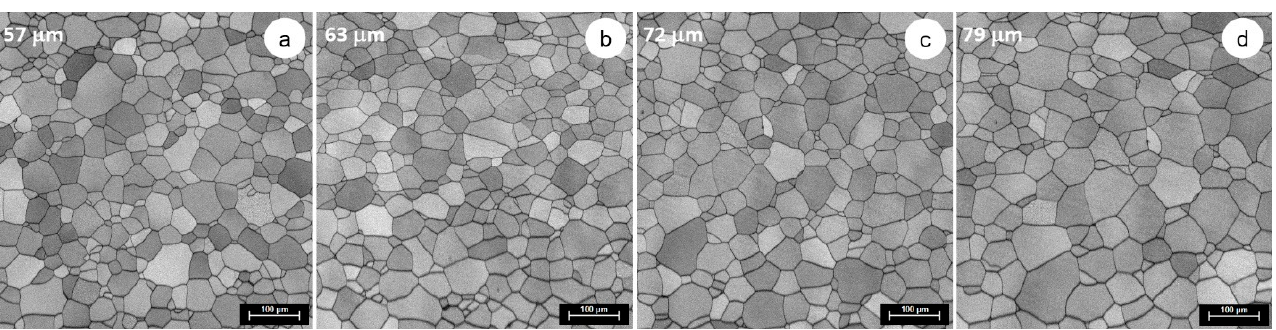
Figure 8. Evolution of the TNTZ alloy microstructure during ST treatment performed at 900 °C for: 5 min (ST 2.1)—( a ); 10 min (ST 2.2)—( b ); 15 min (ST 2.3)—( c ); 20 min (ST 2.4)—( d ).